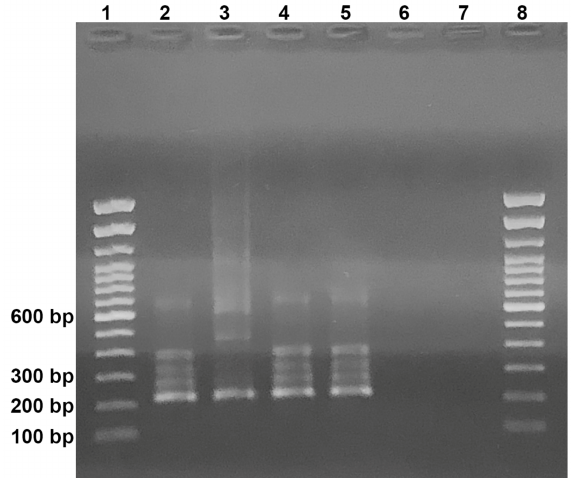
Figure 3. Nested Polymerase chain reaction for H. capsulatum : Slot 1 and 8 = molecular weight (100 bp DNA ladder— ThermoFisher Scientific, Inc.), slot 2 = case 1, slot 3 = case 2, slot 4 = positive control (patient with proven histoplasmosis), slot 5 = positive control (G217B DNA), slot 6 = negative control (patient with COVID-19), slot 7 = negative (water) control. The base pairs (bp) of representative bands are indicated at the